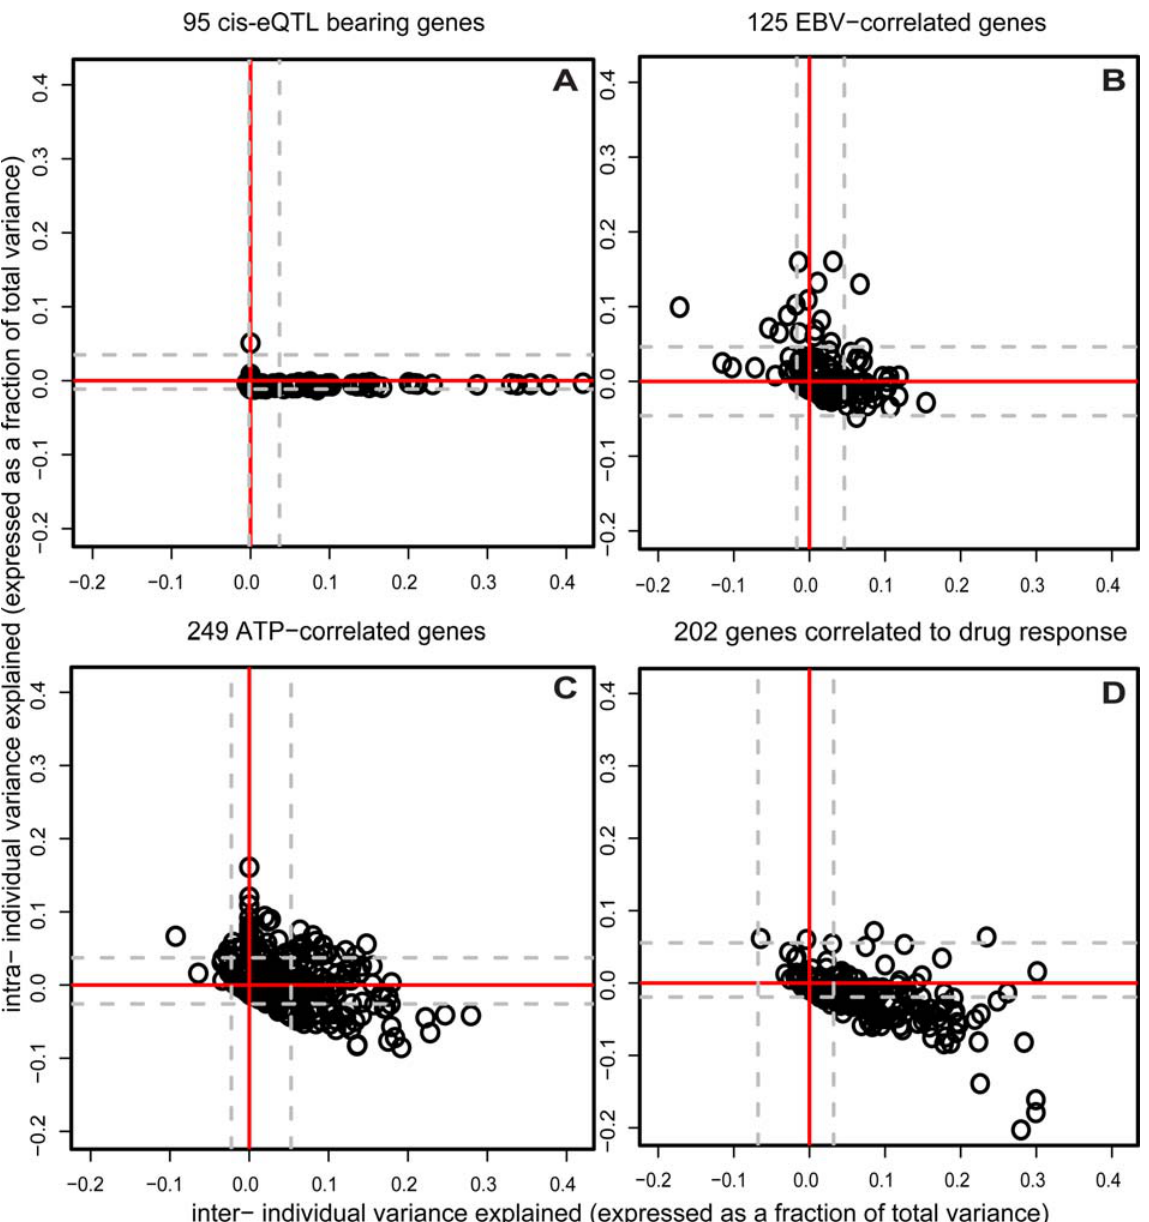
Figure 5. Correlation of eQTLs, EBV, and ATP to inter- and intra-individual variation in RNA expression levels, and correlation of RNA expression levels to inter- and intra-individual variation in drug response. Total variance for each of the 1000 ‘‘best-measured’’ genes was separated into inter- and intra- individual variance components (see Methods) using expression data from the 49 unrelated individuals measured twice at the Broad Institute on the Affymetrix platform. (A) 95 genes with eQTLs that explained . 10% of expression variance (FDR , 10%) in the WTSI dataset were selected (to maximize eQTL detection power) and the SNP genotype was included in the variance components model of the gene to ‘‘account’’ for its effect. 2 1 times the change in each variance component is plotted for each gene. As expected, the plot shows that that SNPs (which remain fixed across experiments) only explain inter-individual variation in expression. Grey dashed lines indicate the inter- and intra- 2.5% and 97.5%- tiles of the distribution of variance component change estimates when the entire analysis is repeated on a permuted dataset. (B) 125 genes correlated to EBV at rho 2 . .05 (FDR , 10%) were selected and the EBV measurement was included in the variance components model of the gene to ‘‘account’’ for its effect. 2 1 times the change in each variance component is plotted for each gene. The plot shows that EBV is correlated to inter- individual differences in gene expression that persist across experiments, intra-individual fluctuation in gene expression between experiments, or both, depending on the gene in question. Grey dashed lines are as in (A). (C) 249 genes correlated to ATP at rho 2 . .05 (FDR , 10%) were selected and the ATP measurement was included in the variance components model of the gene to ‘‘account’’ for its effect. 2 1 times the change in each variance component is plotted for each gene. The plot shows that ATP is correlated to inter-individual differences in gene expression that persist across experiments, intra-individual fluctuation in gene expression between experiments, or both, depending on the gene in question. Grey dashed lines are as in (A). (D) 202 ‘‘drug-response correlated’’ genes were defined as in Figure 6. The expression of each gene was incorporated in a variance components model of the assigned drug response EC50 to examine the correlation of the gene to its strongest correlated drug. 2 1 times the change in the variance components of drug response is plotted for each gene, showing that it is mostly the inter - individual differences in gene expression that are correlated to cell line drug response. Grey dashed lines are as in (A).